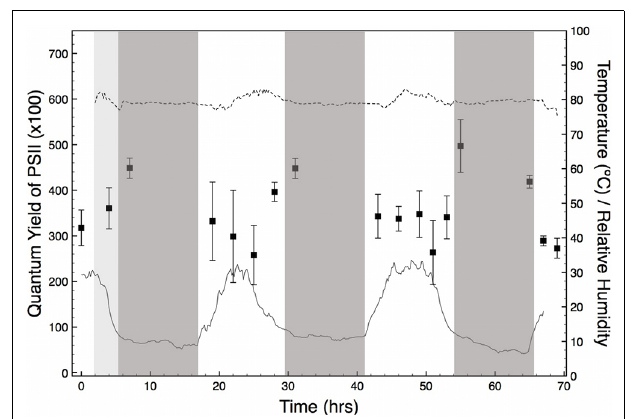
FIGURE 2 | Quantum yield of PS(II) measured in freshly exposed interiors of halite nodules for a period of 4 days and three nights (black squares). Nodules were measured at time intervals of 3 h between dawn and dusk. Each data point is the average of 25–40 measurements obtained from three different nodules. Error bars represent standard deviations. The solid line (T) and dotted line (RH) show the conditions inside a reference nodule measured at time intervals of 10 min for the duration of the experiment. Night periods are indicated as dark-gray. An overcast period with fog at the beginning of the experiment is indicated in light